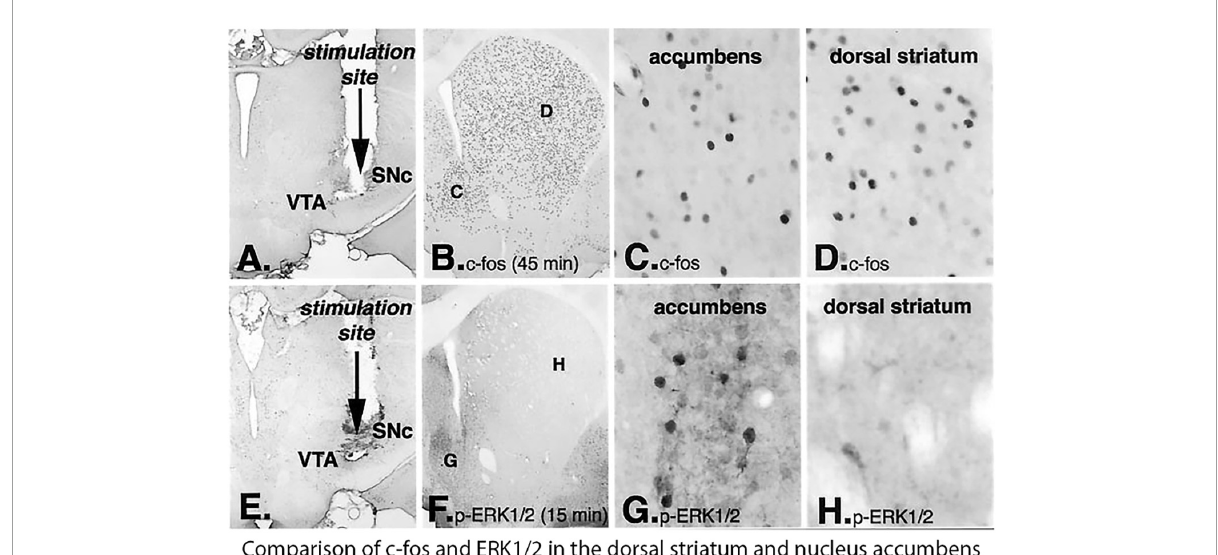
FIGURE5 Electrical stimulation of the nigrostriatal pathway results in the induction of the IEG c- fos throughout the striatum and nucleus accumbens, but activation of ERK1/2 is restricted principally to the nucleus accumbent. Electrodes were placed in the junction between dopamine (DA) neurons in the ventral tegmental area (VTA) and substantia nigra pars compacta (SNc) and stimulated (A,E) . In animals killed 45 min after stimulation onset (A–D) , c-fos is induced throughout the dorsal striatum and nucleus accumbens (B) . Higher-power photomicrographs reveal c-fos-immunoreactive nuclei in the nucleus accumbens (C) and in the dorsal striatum (D) . In animals killed 15 min after stimulation onset (E–H) , the time point that is optimal for detecting phosphorylated ERK1/2, immunoreactive neurons are observed only in the nucleus accumbens (F) . Higher power photomicrographs reveal numerous rons in the nucleus accumbens (G) , whereas in the dorsal striatum, only scattered large immunoreactive neurons are observed (H) and not in SPNs (Gerfen et al.,